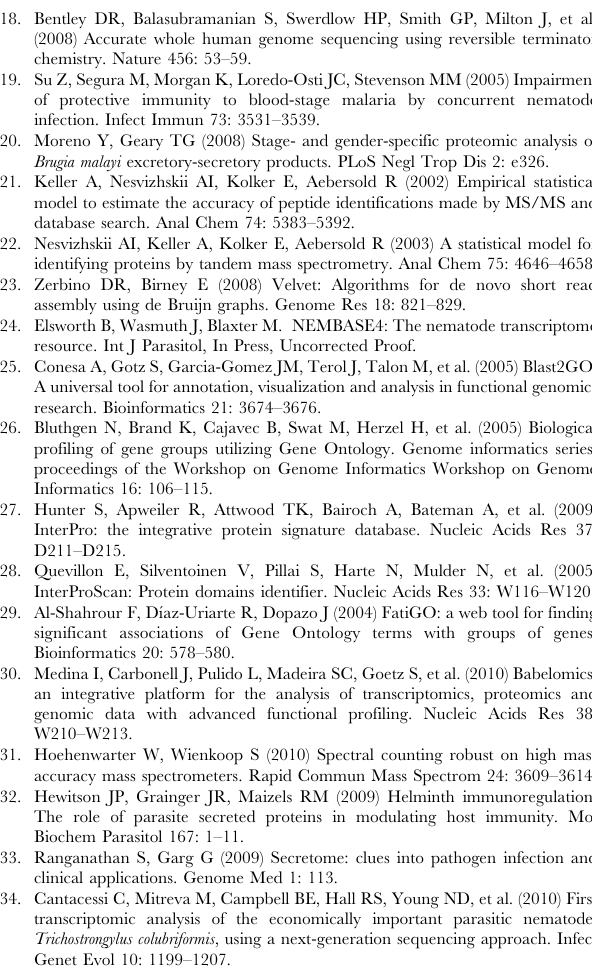
Table S1 Proteins identified in H. polygyrus ESP through search in UniProt database taxon identifier 6231, Nematoda.